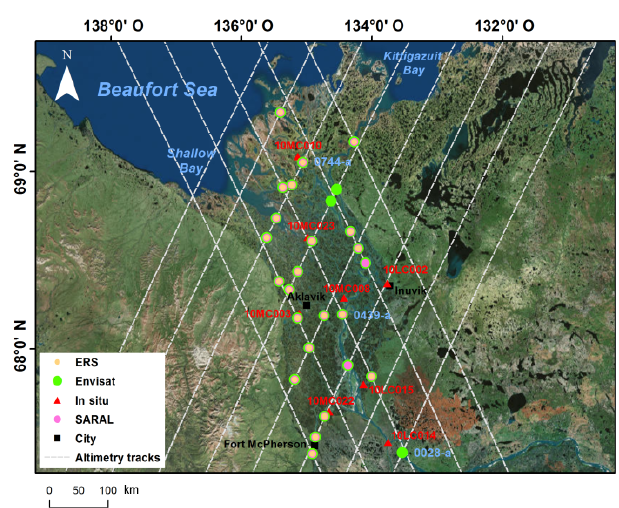
Figure 5. Locations of virtual stations (VSs) in the Mackenzie Delta for ERS-2 (yellow dots), Envisat (green dots) and SARAL (purple dots) altimetry missions. Altimetry tracks appear in grey. In situ stations are represented using red